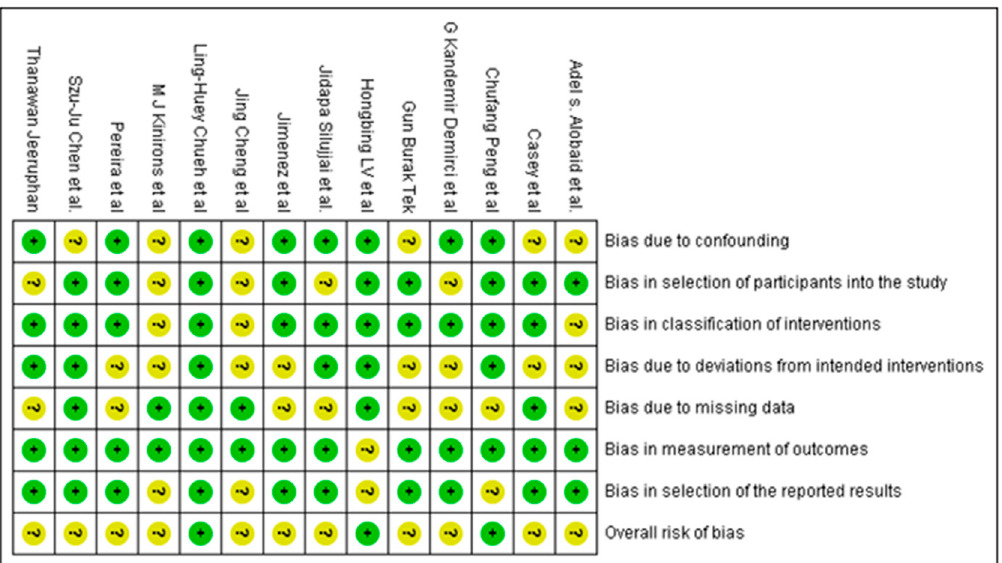
Figure 3. Quality assessment of included NRCT studies summary: review authors’ judgements about each risk of bias item for each included study.